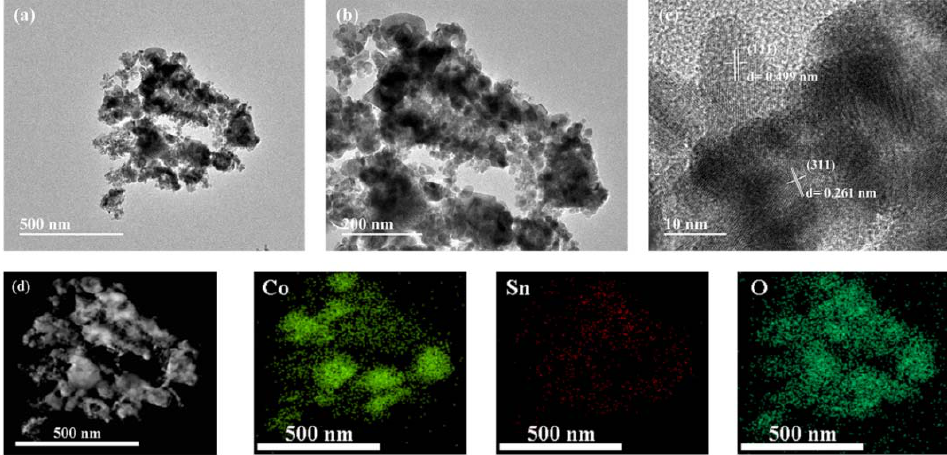
Figure 5. ( a – c )TEM image, and ( d ) the corresponding elemental mapping images of Co, Sn, and O elements, respectively.